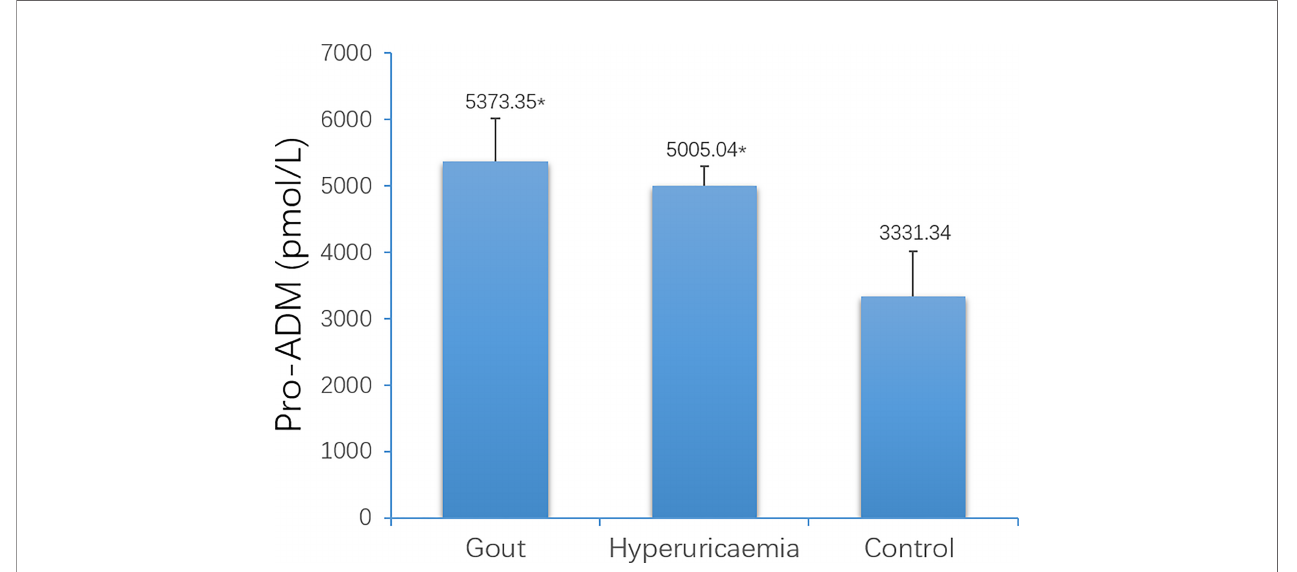
FIGURE 8 | Comparison of serum Pro-ADM levels among gout patients, hyperuricaemia patients and control (*P < 0.05 vs.